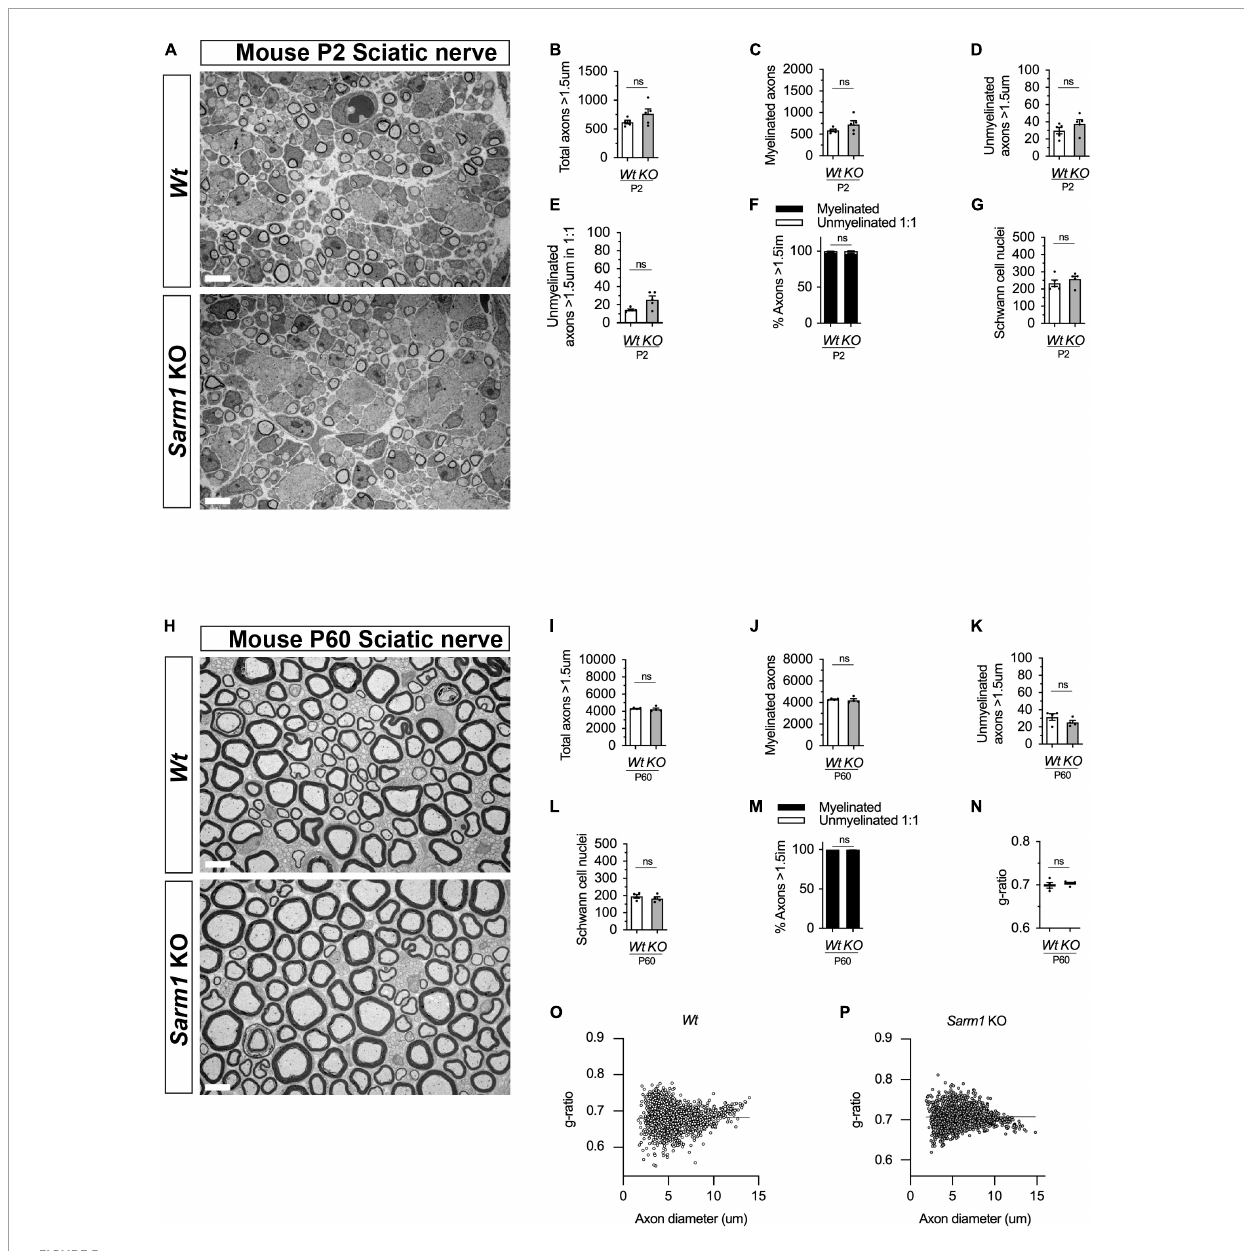
FIGURE5 PNS myelination and myelin maintenance are normal in Sarm1 null mice. (A) Representative electron micrographs taken at x 3,000 magnification from Wt and Sarm1 knockout (KO) sciatic nerves at postnatal day 2 (P2). Scale bar 5 µ m. (B) Per nerve profile, the total number of axons > 1.5 µ m quantified are not significantly different in Wt , 621.0 ± 28.99, and Sarm1 KO, 763.0 ± 86.35, nerves (mean and SEM, n = 5; p = 0.3095). (C) The number of myelinated axons quantified per nerve profile are similar in both Wt , 591.2 ± 26.67, and Sarm1 KO, 725.0 ± 86.37, nerves (mean and SEM, n = 5; p = 0.3095). (D) The number of unmyelinated axons > 1.5 µ m is not significantly different in Wt , 29.8 ± 3.77, and Sarm1 KO, 37.8 ± 4.73, nerves (mean and SEM, n = 5; p = 0.1508). (E) Per nerve profile, the number of unmyelinated axons > 1.5 µ m in a ratio 1:1 is slightly higher in Sarm1 KO, 25.8 ± 3.96, nerves compared to Wt , 14.4 ± 0.98; however, this does not reach significance (mean and SEM, n = 5; p = 0.0873). (F) The percentage of myelinated axons versus non-myelinated axons present in Wt , 97.63% ± 0.19 and Sarm1 KO, 96.4% ± 0.75, nerves is not significantly different ( n = 5; p = 0.1508). (G) The number of Schwann cell nuclei quantified per nerve profile is not significantly different between Wt , 234.0 ± 18.93 and Sarm1 KO, 258.2 ± 16.79 nerves (mean and SEM, n = 5; p = 0.5476). (H) Representative electron micrographs taken at x3000 magnification from adult Wt and Sarm1 KO sciatic nerves at P60. There are no ultrastructural differences in the sciatic nerves of adult Sarm1 KO compared to those of Wt sciatic nerves. Scale bar 5 µ m. (I) Per nerve profile, the total number of axons > 1.5 µ m quantified is similar in Wt , 4341 ± 34.27 and Sarm1 KO, 4241 ± 138.3 sciatic nerves (mean and SEM, n = 4; p = 0.3429). (J) The number of myelinated axons present in Wt , 4310 ± 31.37 and Sarm1 KO, 4216 ± 136.2 nerves is not significantly different (mean and SEM, n = 4; p = 0.3429). (K) Per nerve profile, the number of unmyelinated axons > 1.5 µ m is not significantly different in Wt , 31.5 ± 3.86 and Sarm1 KO, 25.25 ± 2.4 nerves (mean and SEM, n = 4; p = 0.3429). (L) The number of Schwann cell nuclei is similar in both Wt , 196.0 ± 10.34 and Sarm1 KO, 183.3 ± 10.5 nerves (mean and SEM, n = 4; p = 0.4857). (M) The percentage of myelinated versus non-myelinated axons present in both Wt , 99.3 ± 0.09 and Sarm1 KO, 99.41 ± 0.04 nerves is not different (mean and SEM, n = 4; p = 0.3429). (N) Myelin sheath thickness as depicted by g-ratios is similar in both Wt , 0.69 ± 0.007 and Sarm1 KO, 0.704 ± 0.003 nerves (mean and SEM, n = 4; p = 0.4857). (O) Scatter plot of g-ratio as a function of axonal caliber in Wt sciatic nerves. (P) Scatter plot of g-ratio as a function of axonal caliber in Sarm1 KO sciatic